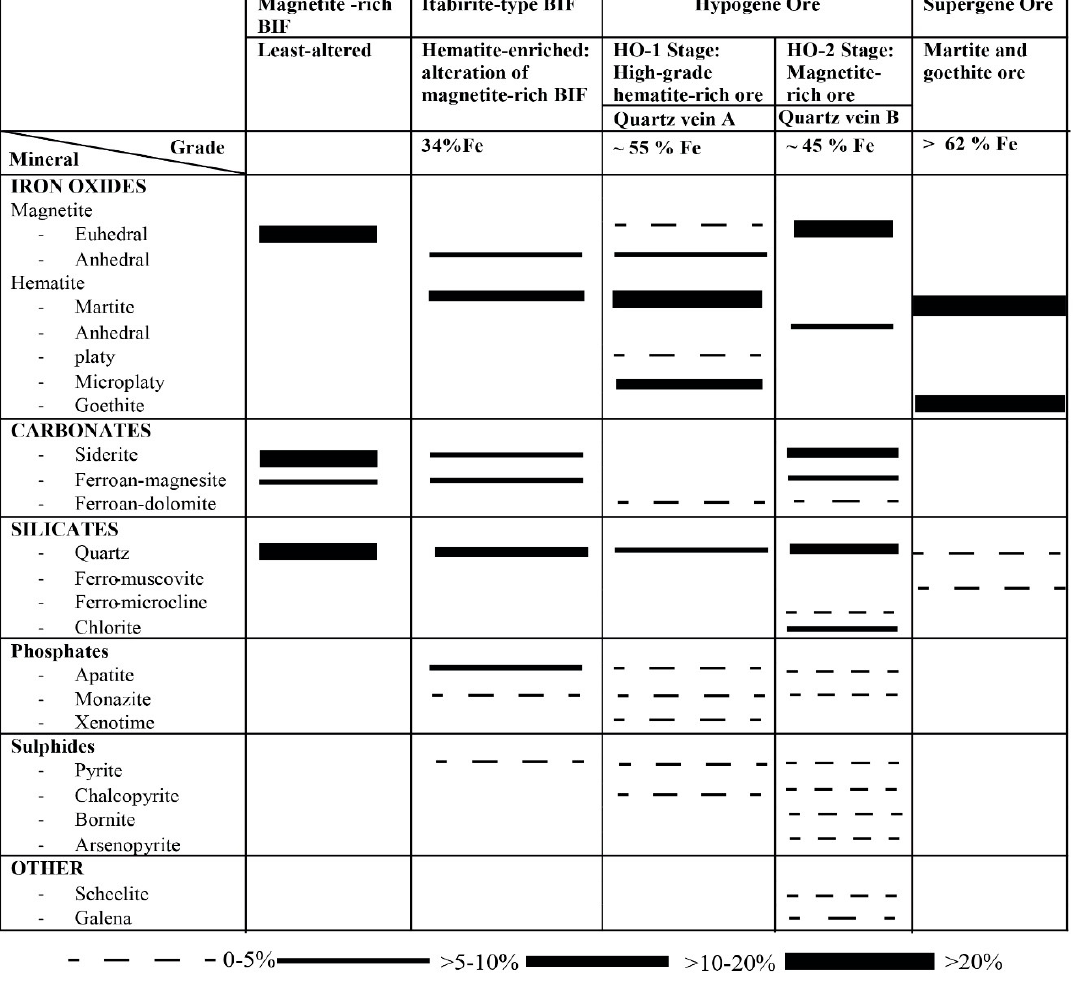
Figure 5. Paragenetic sequence of mineralization in the Nabeba deposit.